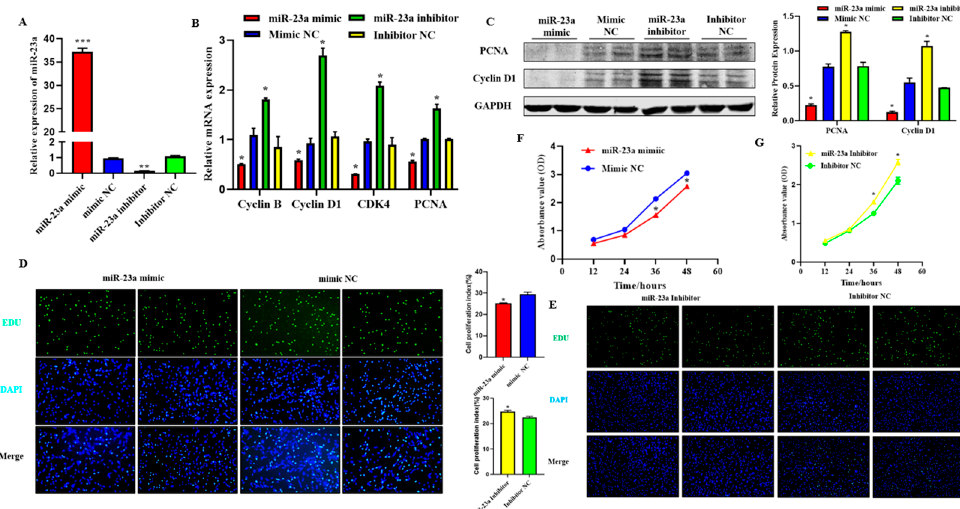
Figure 4. Effect of miR-23a on adipocyte proliferation. ( A ) Expression levels of miR-23a in adipocytes by qPCR. ( B ) Expression levels of cyclin B, cyclin D1, CDK4, and PCNA in adipocyte by qPCR. ( C ) Expression levels of Cyclin D1 and PCNA by Western blot. ( D , E ) Cell proliferation analysis using the EdU assay. ( F , G ) Cell proliferation analysis using Cell Counting Kit 8 (CCK-8) assay. * p < 0.05, ** p < 0.01, *** p < 0.001.